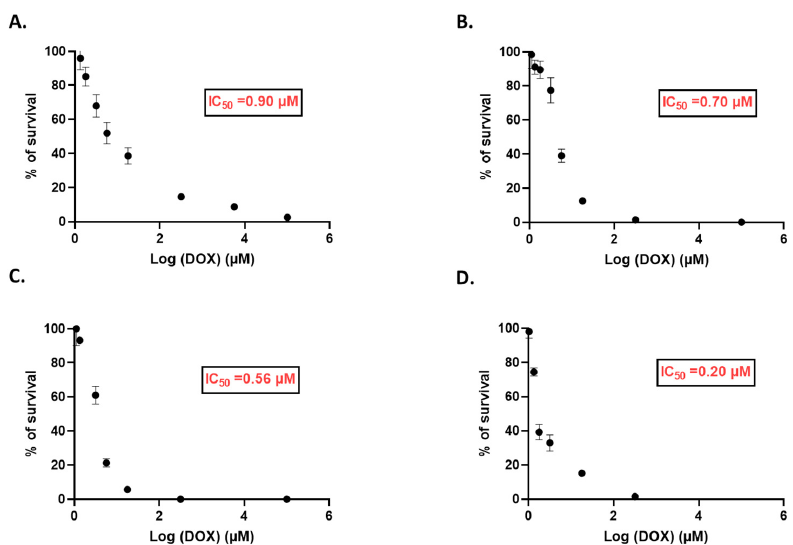
Figure 9. IC 50 values of Doxorubicin on SK-BR-3 cells, determined at different time points: ( A ) 4 h, ( B ) 24 h, ( C ) 48 h, and ( D ) 72 h using the MTT cytotoxicity assay. ( B ) 24 h, ( C ) 48 h, and ( D ) 72 h using the MTT cytotoxicity assay.